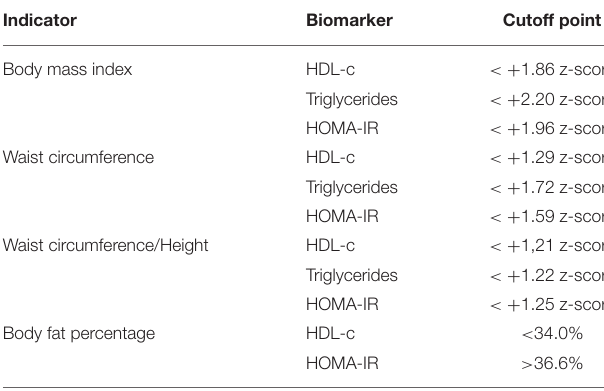
TABLE 3 | Cutoff points according to Younden’s “J” index analysis to rule out or predict biochemical abnormalities or body fat percentage obtained from data from children and adolescents aged 5 to 18 years from two Brazilian overweight and obesity outpatient